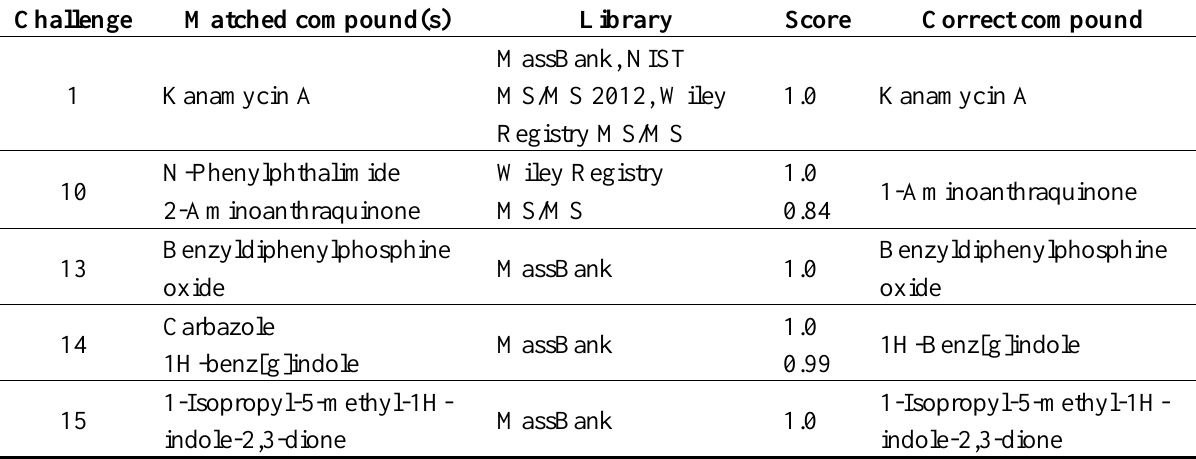
Table 1. Putative identifications